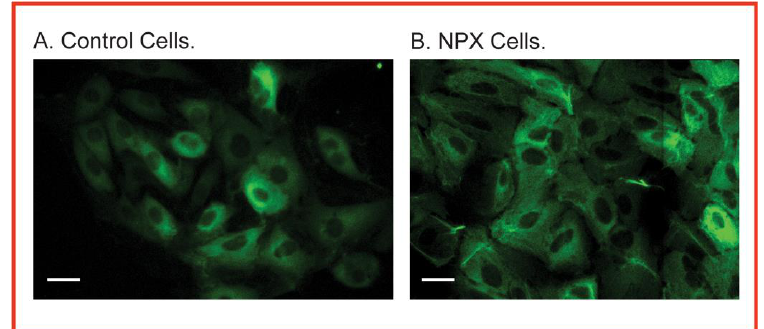
Figure 2. Immunofluorescent staining for cytokeratins in renal PT cells from control and NPX rats on day 5 of primary culture. Freshly isolated PT cells from control ( left ) or NPX ( right ) rats were seeded at a density of 0.5–1.0 x 10 6 cells/mL and allowed to grow for 5 days. Cells were then washed twice with sterile phosphate-buffered saline, and cytokeratin expression was visualized using a monoclonal fluorescein isothiocyanate-conjugated anti-mouse cytokeratin antibody. Note the enlarged size of many of the PT cells from the NPX rats relative to that of the PT cells from the control rats. Photomicrographs were taken at 100X magnification on a Zeiss confocal laser microscope. Bar = 5 mm. Adapted from [22].